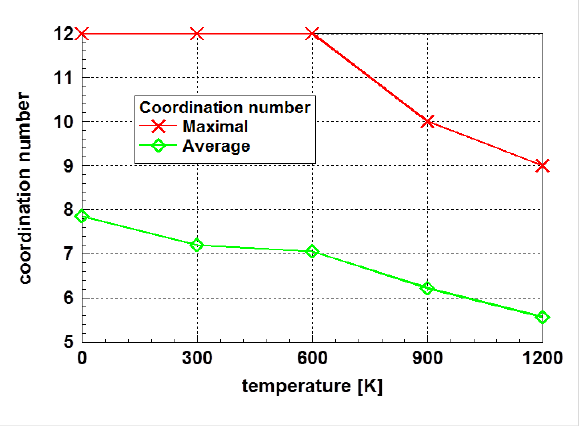
Figure 4: Development of the maximum and the average coordination number of the originally crystalline cluster as a function of the annealing temperature. The reduction of the highest coordination num- ber to values below twelve indicates a complete loss of